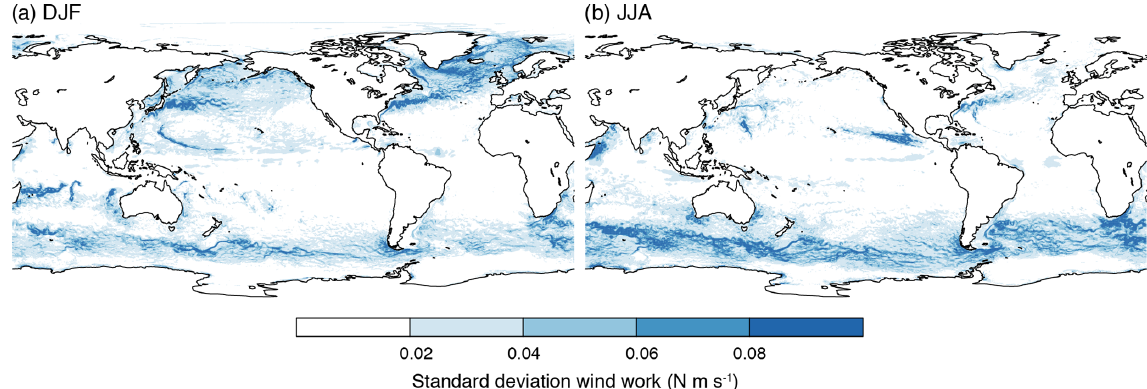
Figure 10. Standard deviation of wind work in G_AO_5km based on daily values for (a) DJF and (b)